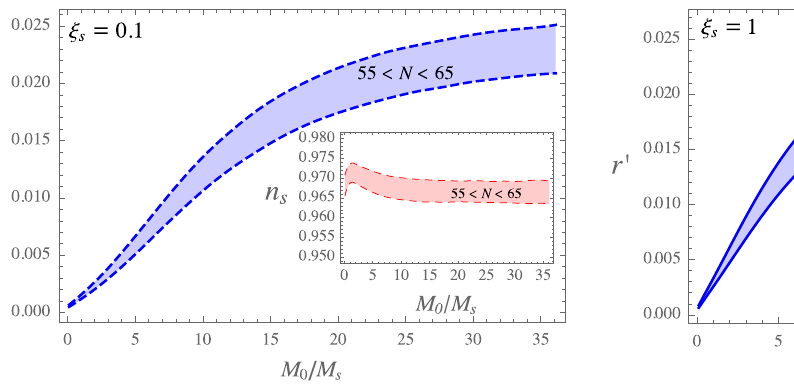
text). The corresponding values of r are given in Eq. (8.4). The insets show the values of n s . An interval of e-folds of 55 < N < 65 is con- sidered ( N suppresses r (cid:6) and enhances n s ). The plot on the left show the results for ξ s = 0 . 1, while that on the right for ξ s =